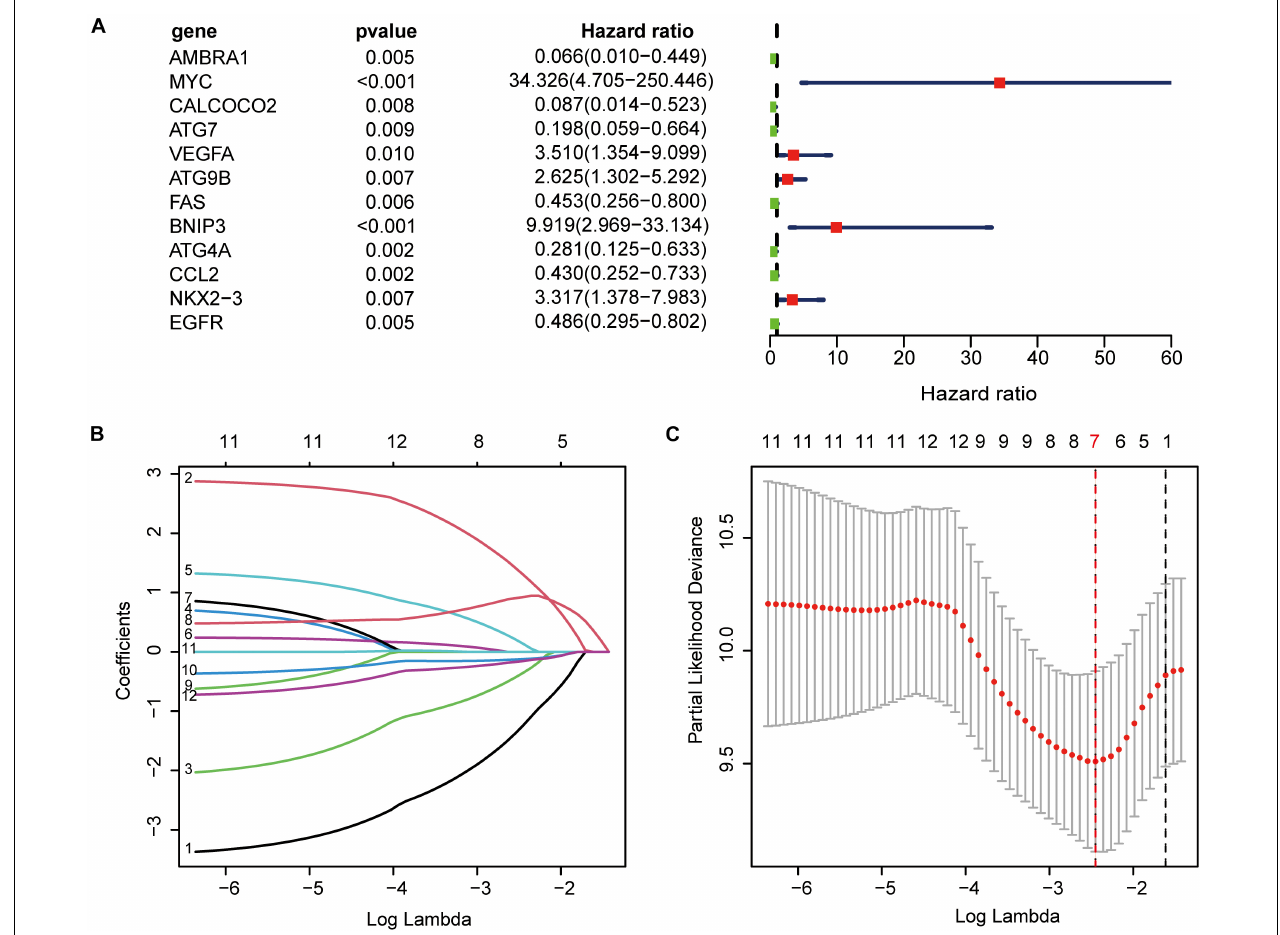
FIGURE 5 | Construction of the autophagy-related prognostic signature. (A) Univariate cox regression showed 12 ARGs related to osteosarcoma survival. (B) LASSO coefficient spectrum of the 12 genes. Coefficients refers to the risk coefficient corresponding to each gene. (C) Selection of the optimal λ